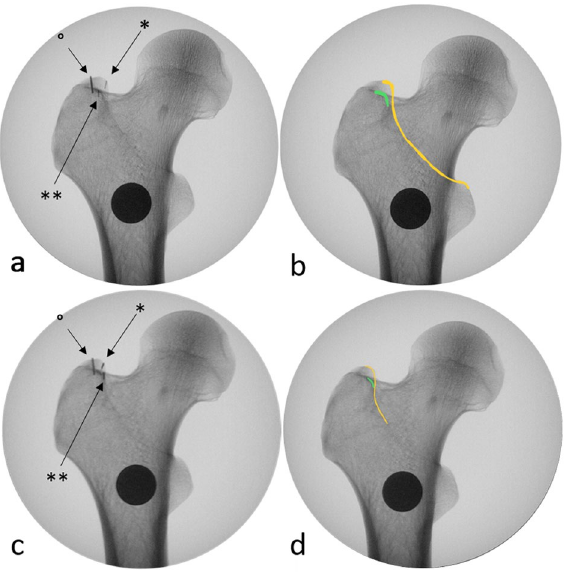
Figure 4. Defining the radiological landmarks. ( a , b ) and ( c , d ) are each pairs of an identical radiological view of the proximal femur. ( c , d ) both show the COV while ( a , b ) show an ap view, which deviates from the COV by 10° external rotation. ( a ) xray image with markers indicating the postero-superior border of the GT (*) and the anterio-superior border of the GT (**) as well as the tip of the GT (°). ( b ) the postero-superior border of the GT is the extension of the intertrochanteric crest (yellow). A density line of the piriform fossa is easily recognized (green). ( c , d ) the antero- and postero-superior borders of the GT overlap in the COV, this coincides with an overlapping of the easily recognizable intertrochanteric crest and density line of the piriform fossa.